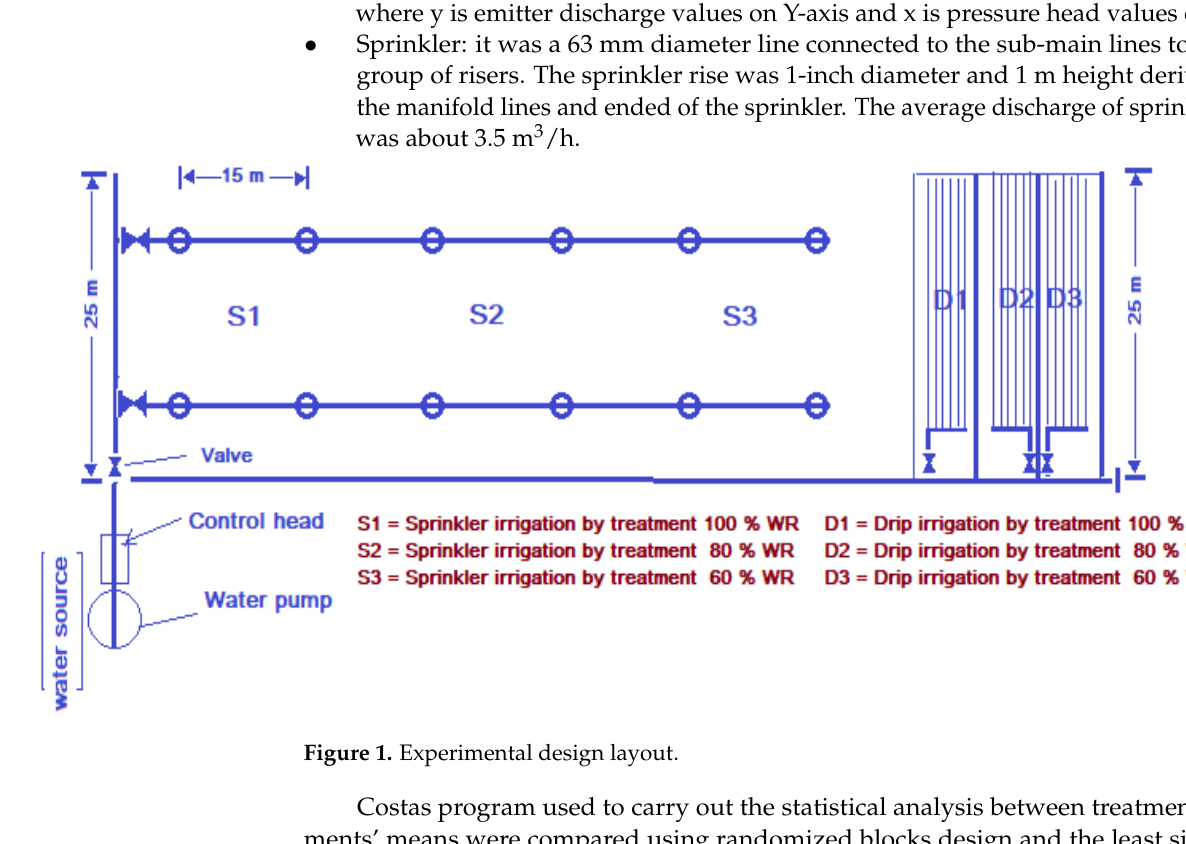
Figure 1. Experimental design layout.